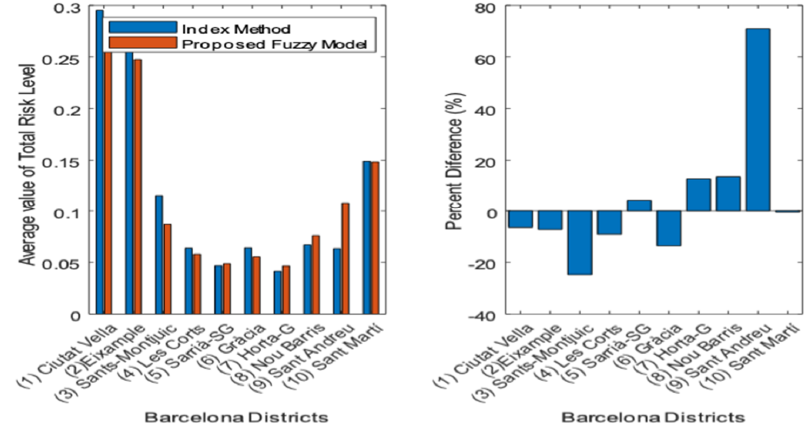
Figure 13. Percentage differences between the numeric value of the total risk estimations made by the index method and the fuzzy model for Barcelona’s districts. At left: values for each of Barcelona’s ZEPs, grouped and averaged per district. At right: percentage difference.